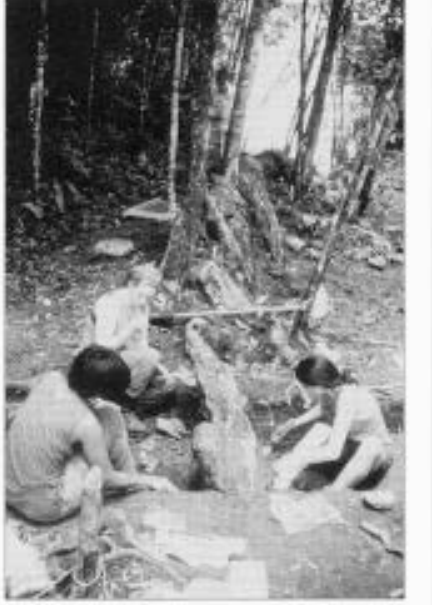
Figure 4 Excavation in progress at Trench A on the southern side of the batey court, site U-53,